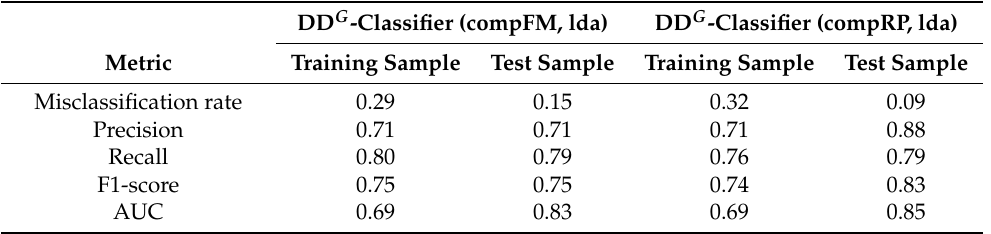
Table 2. Table summarizing the performance of the DD G -classifier using compositional FM-depth (Columns 2 and 3) and compositional RP-depth (Columns 4 and 5), with linear discriminant analysis as the classification rule. Column 1 lists the type of metric, while Columns 2 and 4 show the results of the metrics for the training sample and Columns 3 and 5 show the results for the test